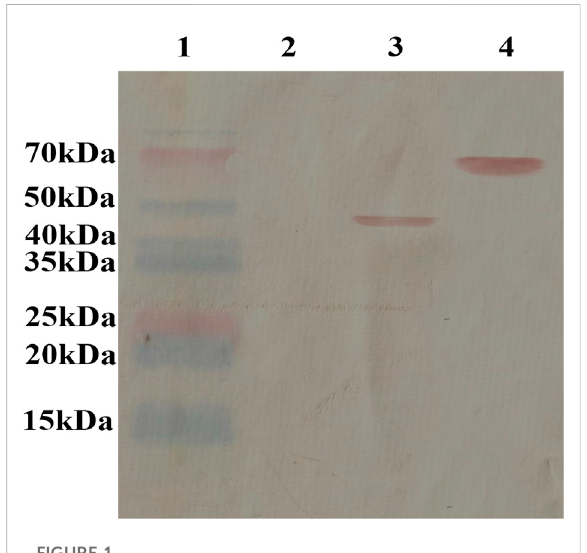
FIGURE 1 Protein expression of PG detected using western blotting. The antimicrobialpeptide antibodyreactedwith thefusion protein in the hybrid phage, and the results showed that the antimicrobial peptide GK protein was displayed on the surface of the recombinant phage. Lane 1: marker (P12083); Lane 2: WT